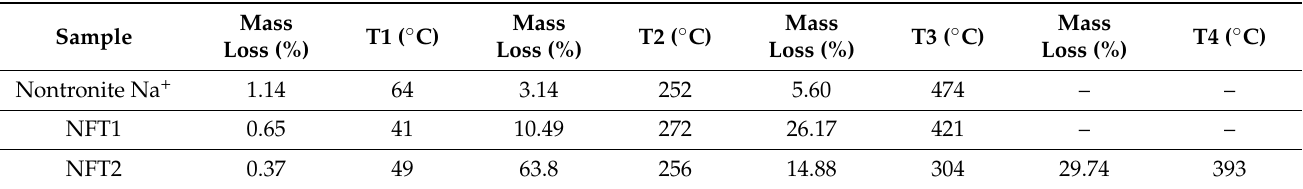
Table 5. Degradation temperatures and mass loss of clays and organoclays.